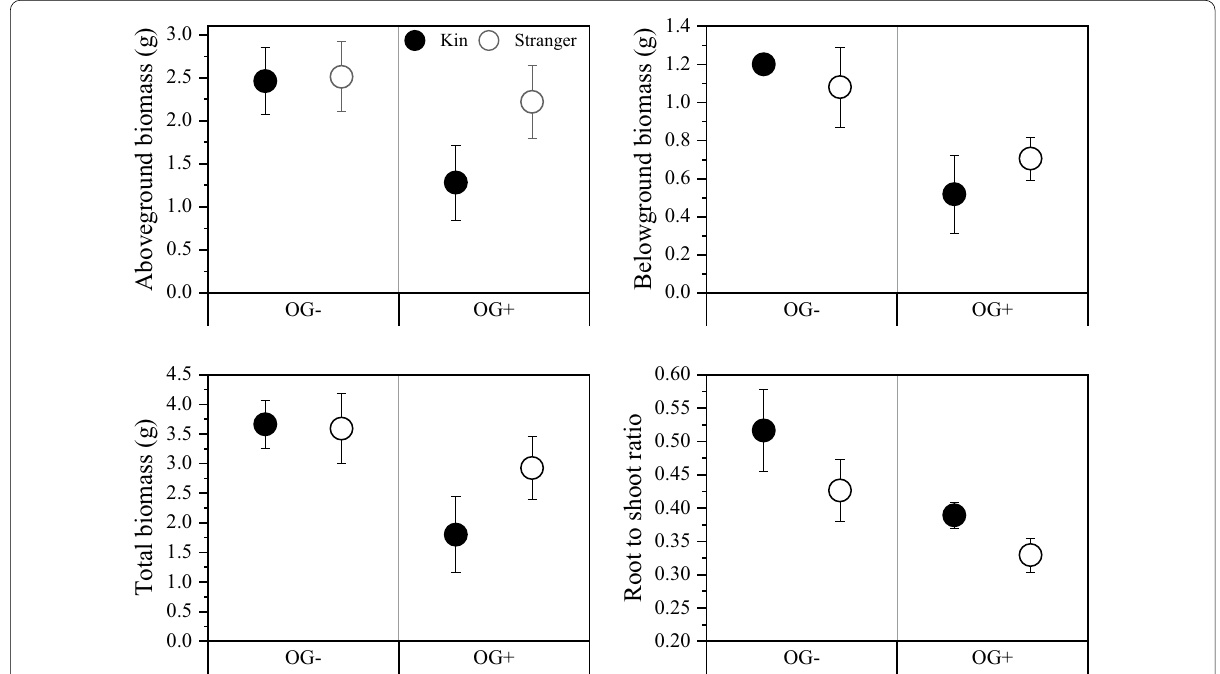
Fig. 2 Effects of neighbor identity and grazing history of grazing on aboveground biomass, belowground biomass, total biomass, and the root– shoot ratio of Leymus chinensis offspring. OG-, offspring of L. chinensis that have not experienced grazing, OG